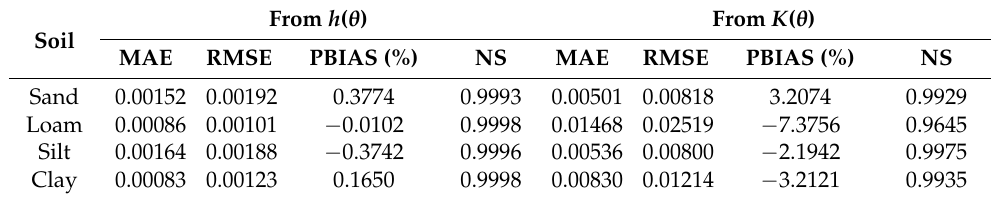
Table 4. Soil water content errors calculated from SWRCs and SWCCs for the four typical soils.